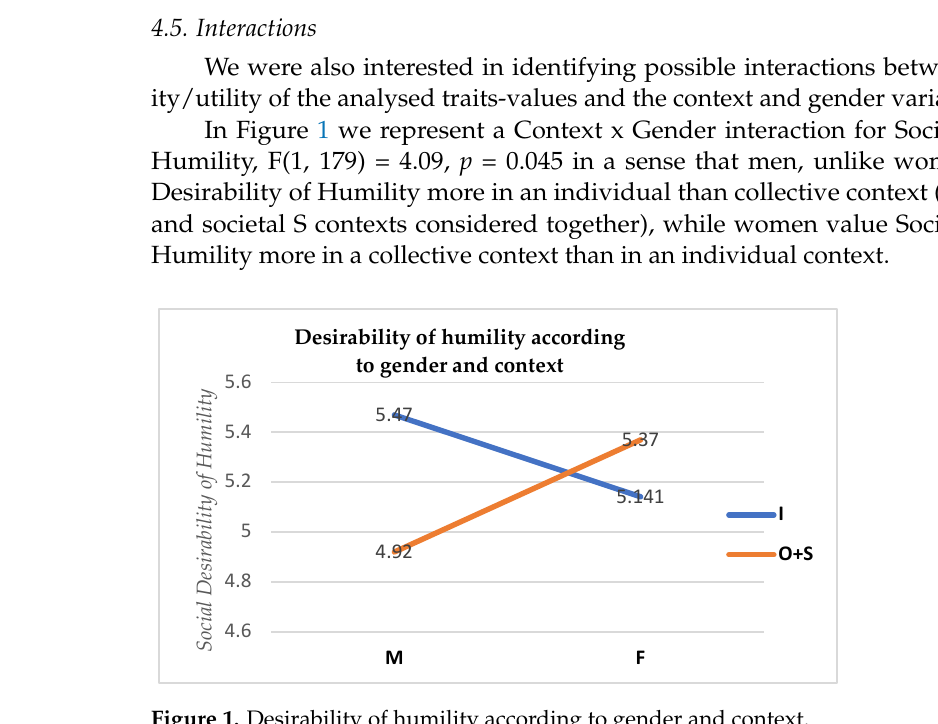
Figure 1. Desirability of humility according to gender and context.